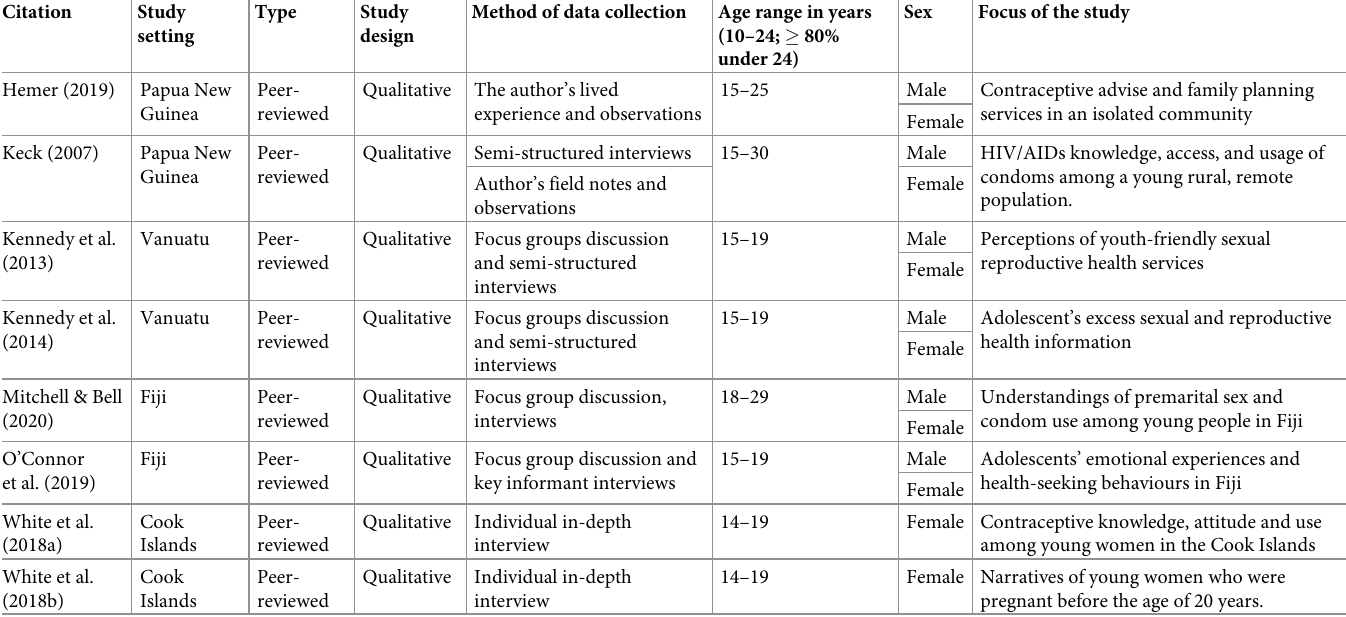
Table 1. Summary of the included